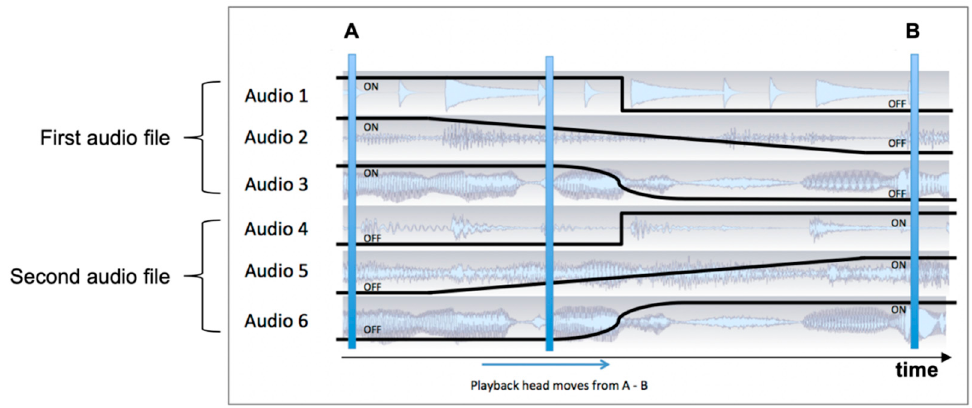
Figure 8. For a given audio cluster, transitioning from A to B might involve any of Audio 1–3 fading to any of Audio 4–6, thus demanding pitch and time metadata to optimize timing and shape of the